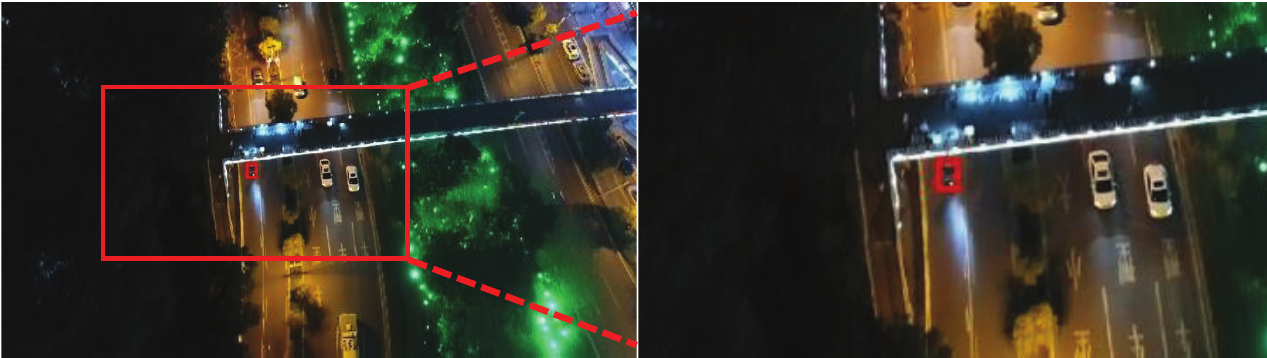
Figure 3. An example of obtaining an object